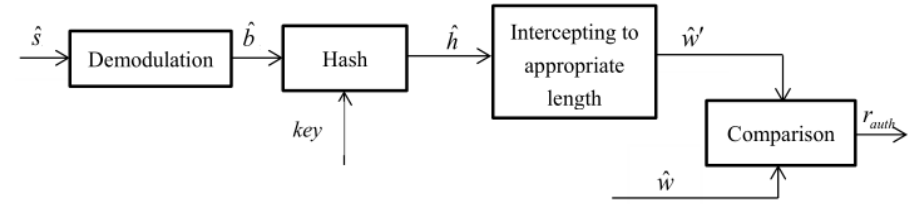
Figure 5. Basic watermark authentication scheme.